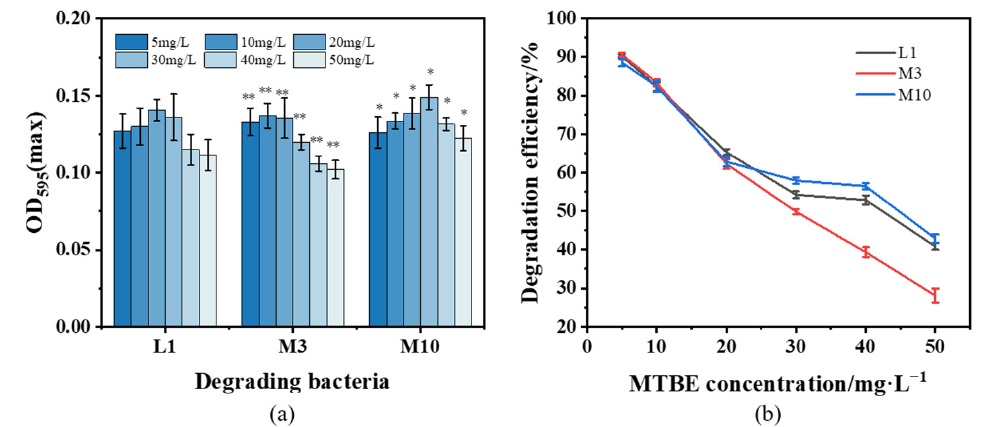
Figure 1. The growth and removal of MTBE with different concentration by three pure strains. The ( a ) biomass (OD 595 ) and ( b ) degradation efficiency of MTBE was determined after incubation for 72 h at 25 °C under shaking condition (160 rpm). The error bars represented standard deviation of three independent data. * represents p < 0.05; ** represents p < 0.01.